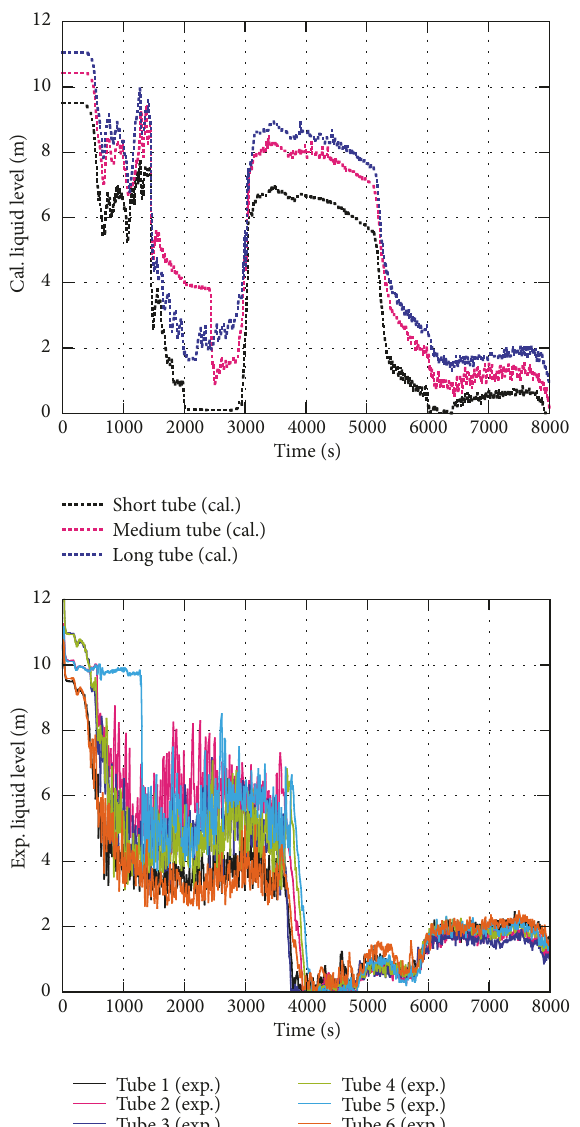
Figure 9: TR-LF-18 test and RELAP5 results for SG U-tube upflow- side collapsed liquid level in loop B.